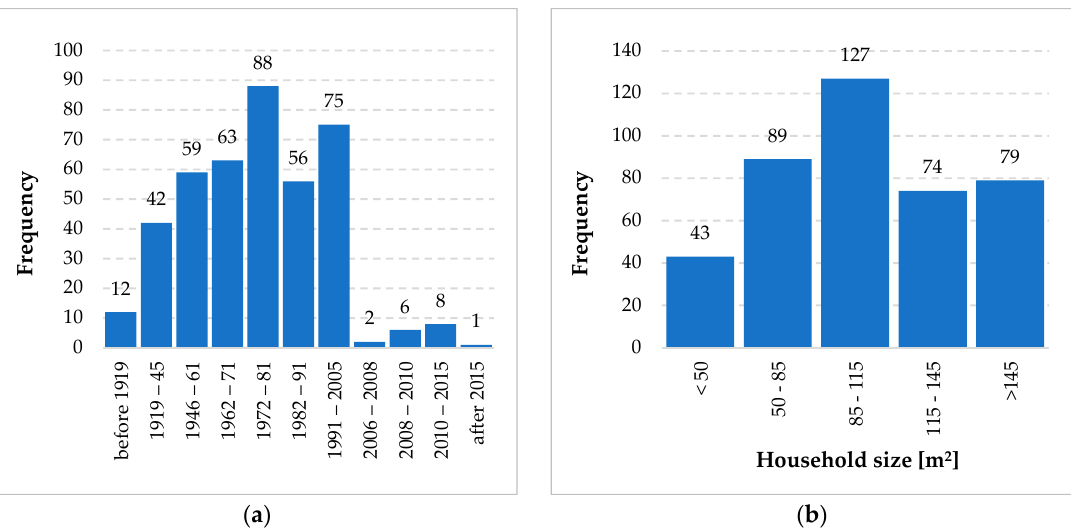
Figure 2. Buildings' subdivision. ( a ) Year of Construction; ( b ) Surface. Figure 2. Buildings’ subdivision. ( a ) Year of Construction; ( b ) Surface.